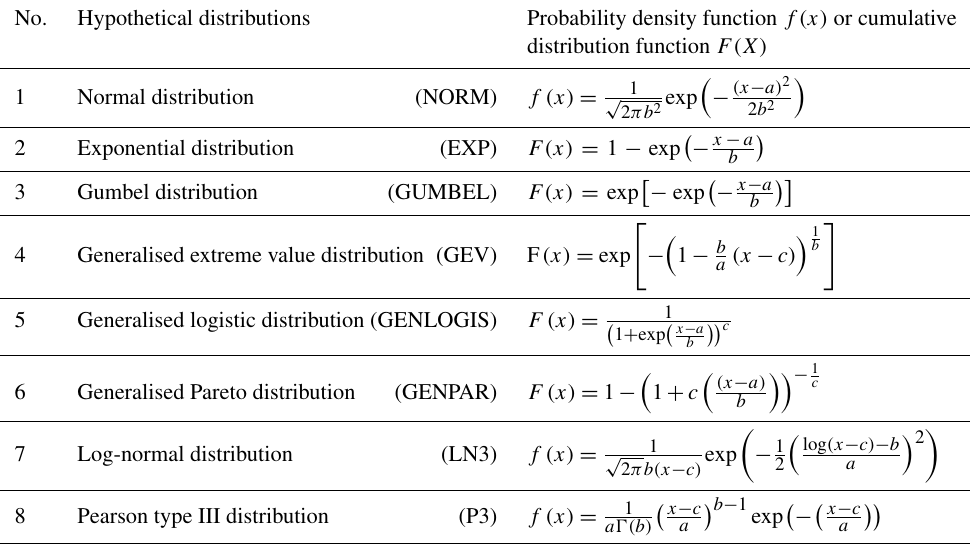
Table D1. Hypothetical distributions adopted in this